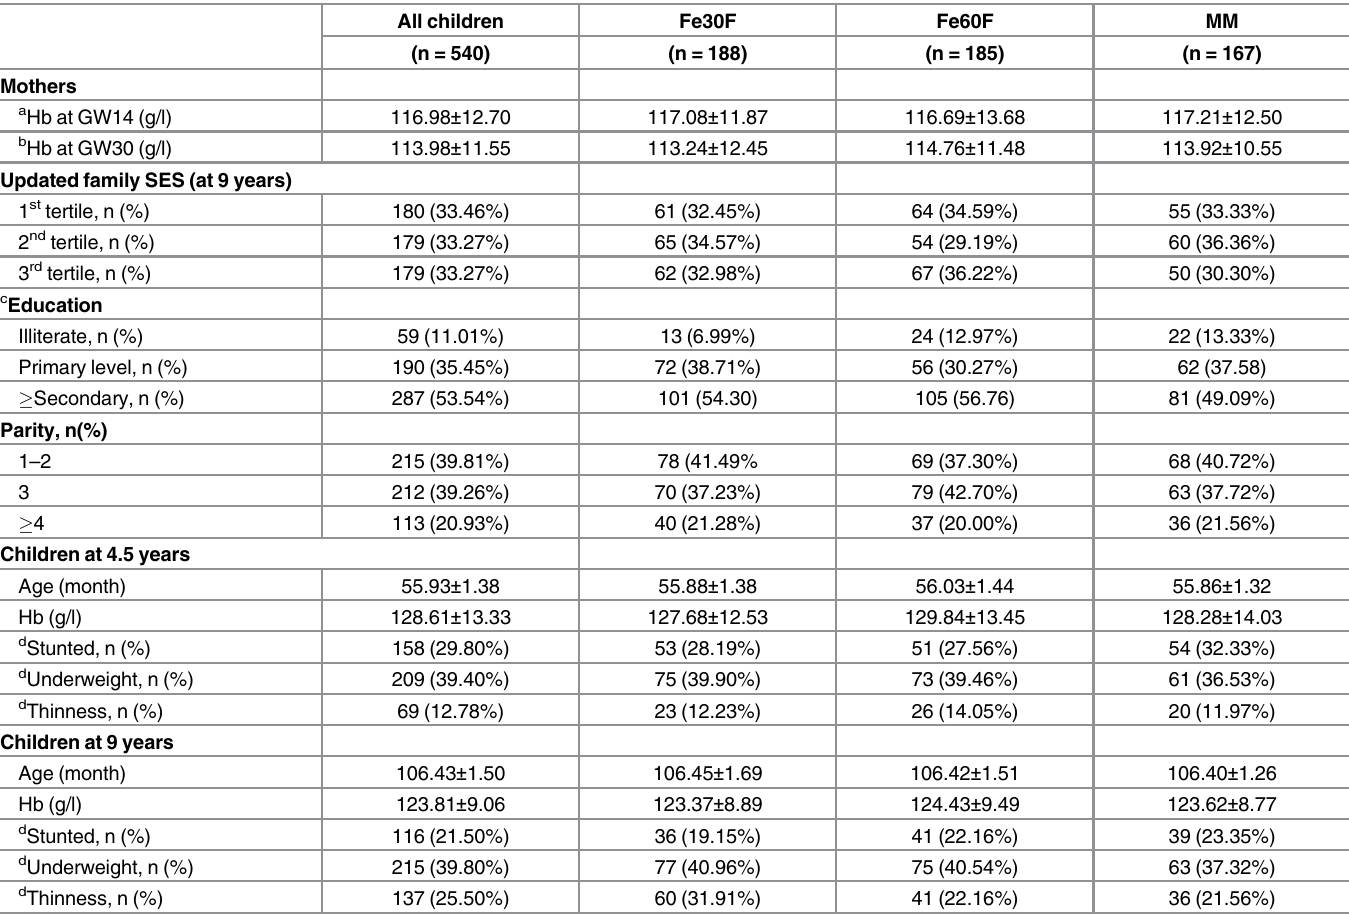
Table 1. Basic characteristics of mothers and their